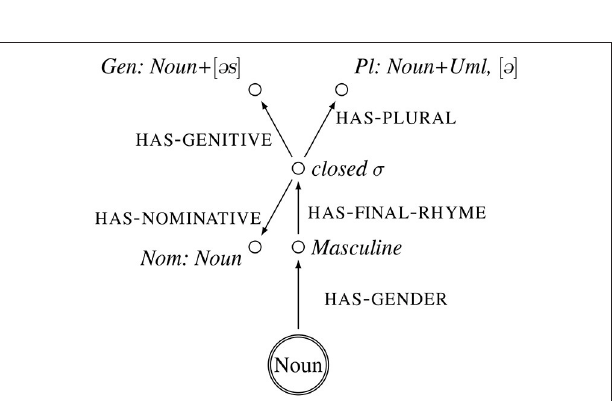
FIGURE 2 | Frame representation of the inflectional class of nouns such as [ bA5t ] “beard.” Uml(aut) indicates a fronted vowel, such that the plural is [ bE5t@